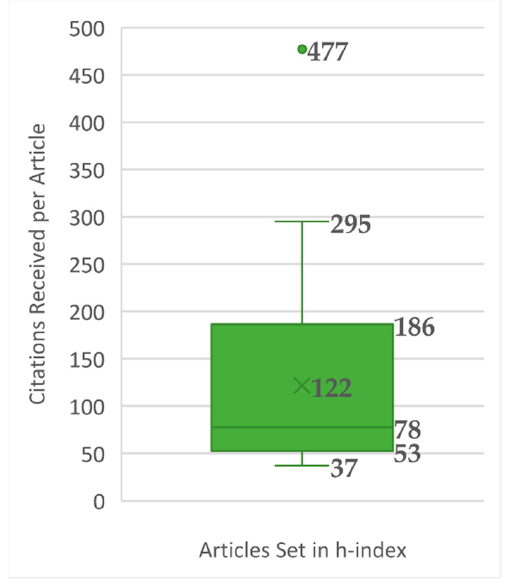
Figure 5. Box plot of citations received per article on coffee/caffeine and sport.